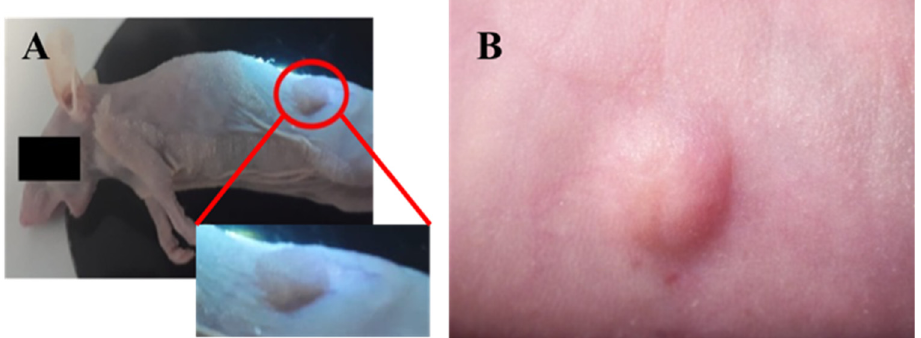
Figure 2. Macroscopic characterization of tumors developed in the presence of humanized stroma after 8 weeks of transplantation. ( a ) Tumor developed by protocol 1; ( b ) tumor developed by protocol2.